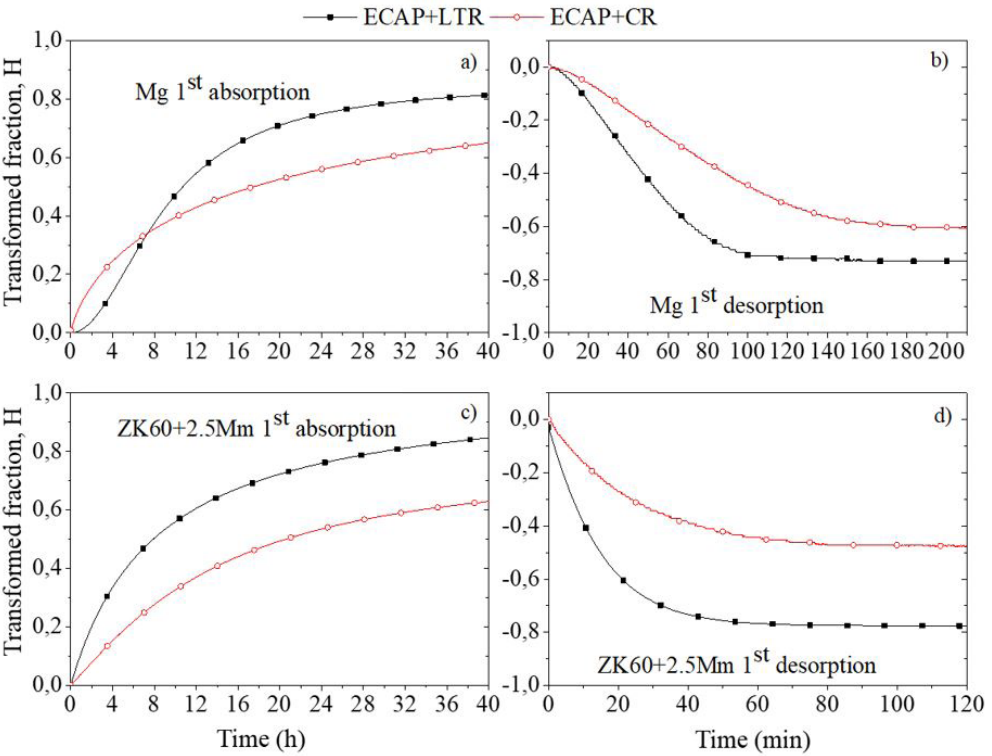
Figure 7. Kinetic curves of (a,c) first absorption (activation) and (b, d) first desorption of pure Mg and ZK60+2.5Mm alloy, respectively.